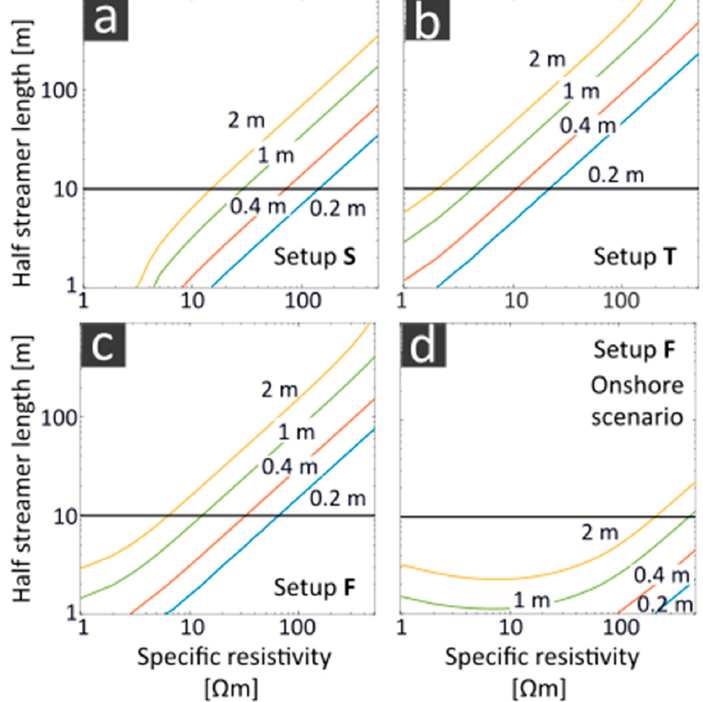
Figure 11. Required streamer length ( y -axis) to resolve the specific resistivity of the homogeneous half space of a 2L case ( x -axis) with a tolerance of 100%. We differentiate between ( a–c ) a shallow water and ( d ) an onshore scenario and the measurement setups ( a ) S (submerged), ( b ) T (towed) and ( c, d ) F (floating). We used water depths from 0.2 to 2 m.